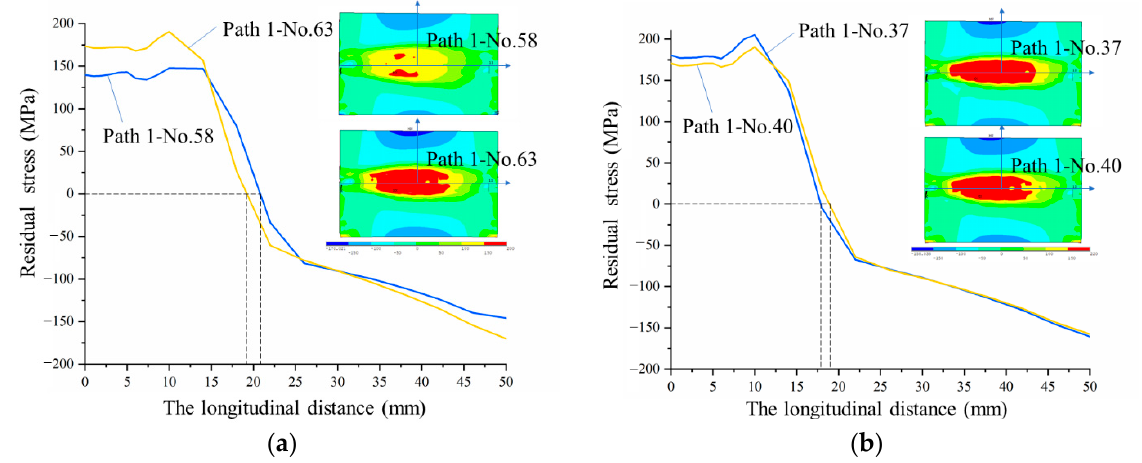
Figure 12. Residual stress curve along path 1 at different welding speeds and areas. ( a ) Residual stress curves of groups 58 and 63; ( b ) residual stress curves of groups 37 and 40.